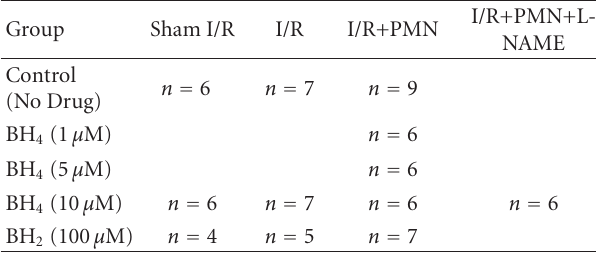
Table 2: Experimental groups in observation of postreperfused cardiac function from the isolated perfused rat